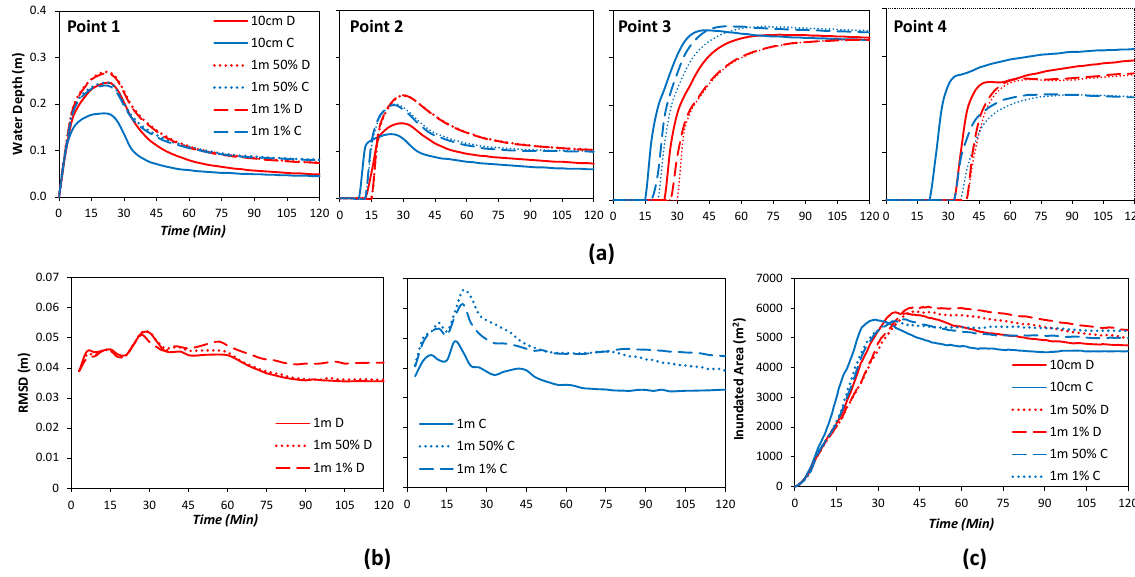
Fig. 12. (a) Comparison of simulated water depth through time at the four control points between 10cm models using distributed ( D ) and composite ( C ) friction and 1m models using 50 and 1% of distributed and composite friction values. (b) Comparison of RMSD through time between the benchmark 10cm models with distributed ( D ) and composite ( C ) friction and the 1m models using 100, 50 and 1% of distributed and composite values. (c) Comparison of inundated area between benchmark 10cm models using distributed and composite friction and 1m models using 50 and 1% of friction